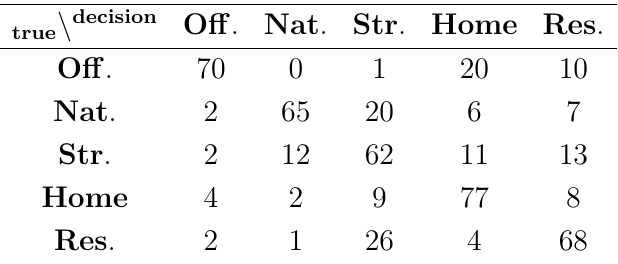
Table 8. Confusion matrix of five environment classes office , nature , street/road , home and restaurant/pub/cafe using the decision tree classifier. The values denote percentages.